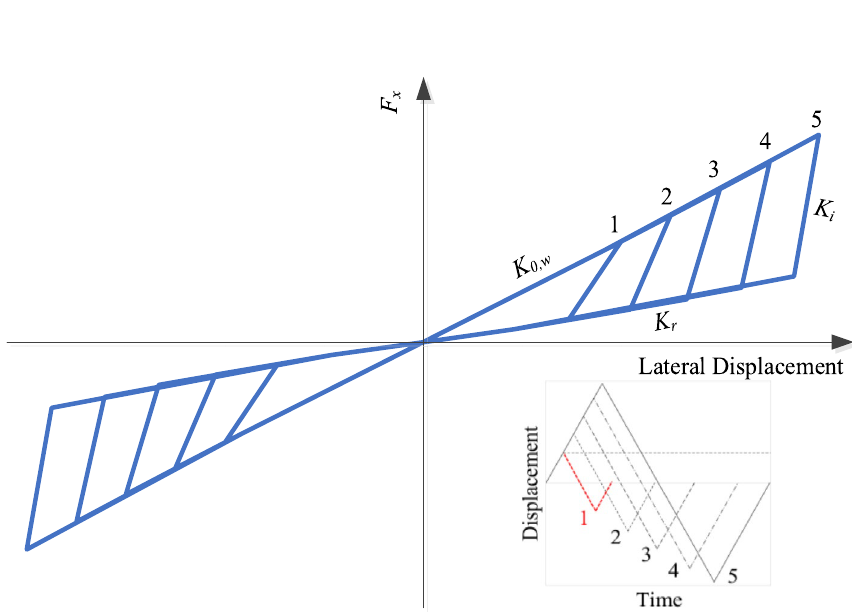
Fig. 3 The constitutive model of C-SMAW (Hedayati Dezfuli and Alam 2015 and Li et al.